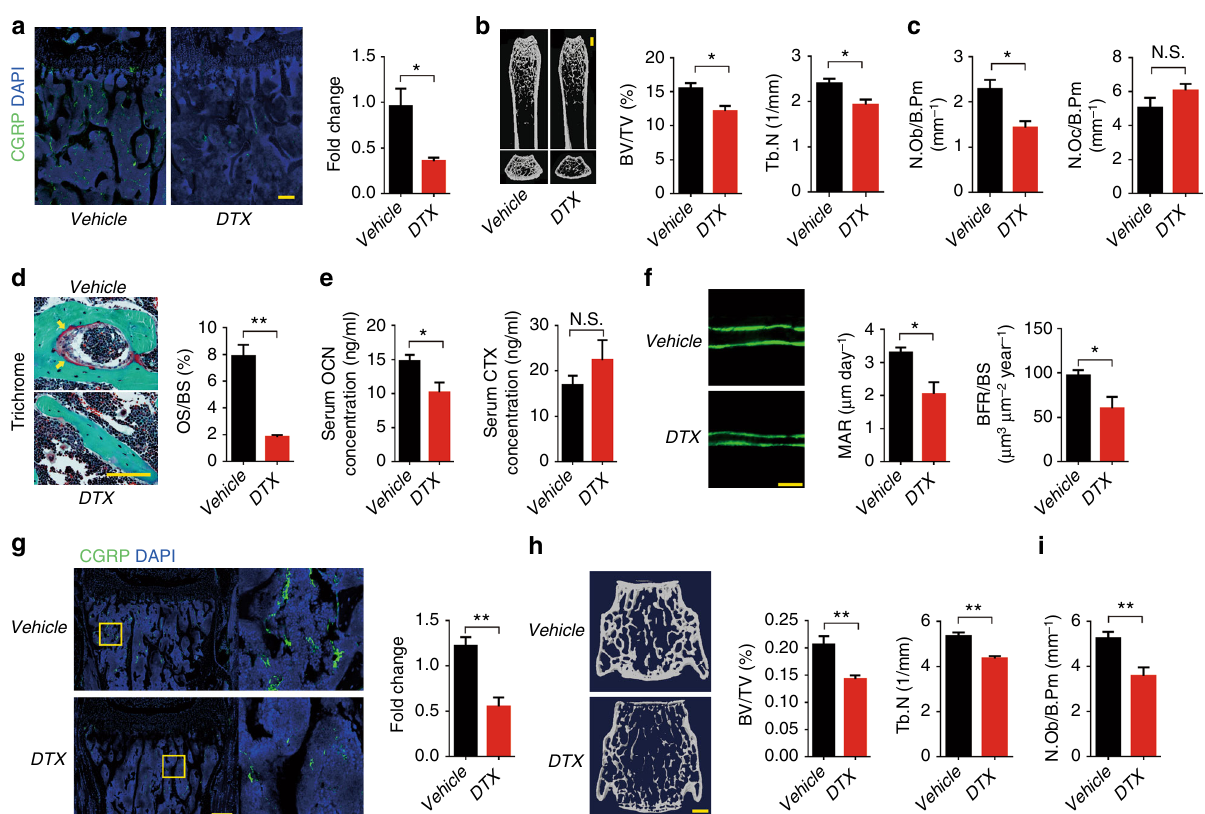
Fig. 2 Osteoblastic bone formation is blunted after sensory denervation. a Representative images of immuno fl uorescence staining and quantitative analysis of the CGRP + sensory nerves in the femurs of 8-week-old iDTR Avil + / − mice injected with vehicle or 1 ug per kg per day DTX 3 time a week for four consecutive weeks. Scale bar: 100 μ m. b Representative μ CT images of femurs from iDTR Avil + / − mice injected with vehicle or DTX. Quantitative analysis of trabecular bone fraction and trabecular number. Scale bar: 1 mm. c Histomorphological analysis of the osteoblast (N.Ob/B.Pm) and osteoclast (N.Oc/B. Pm) numbers on the trabecular bone surface of femurs of iDTR Avil + / − mice injected with vehicle or DTX. d Representative trichrome staining and quantitative analysis of OS/BS in femoral bone tissue from iDTR Avil + / − mice injected with vehicle or DTX. Scale bar, 50 μ m. e ELISA analysis of serum OCN and CTX levels in iDTR Avil + / − mice injected with vehicle or DTX. f Representative images of calcein double labeling of femoral trabecular bone with staining and quantitative analysis of the CGRP + sensory nerves (green) in the vertebra of iDTR Avil + / − mice injected with vehicle or DTX. DAPI stains